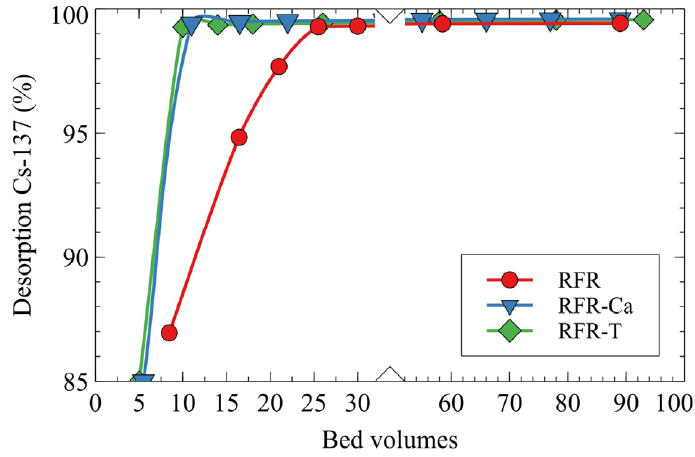
Figure 7. Desorption of Cs-137 by 1M HNO 3 solution under dynamic conditions, grain size—0.1–0.2 mm, solution flow rate—7.5 BV/h.